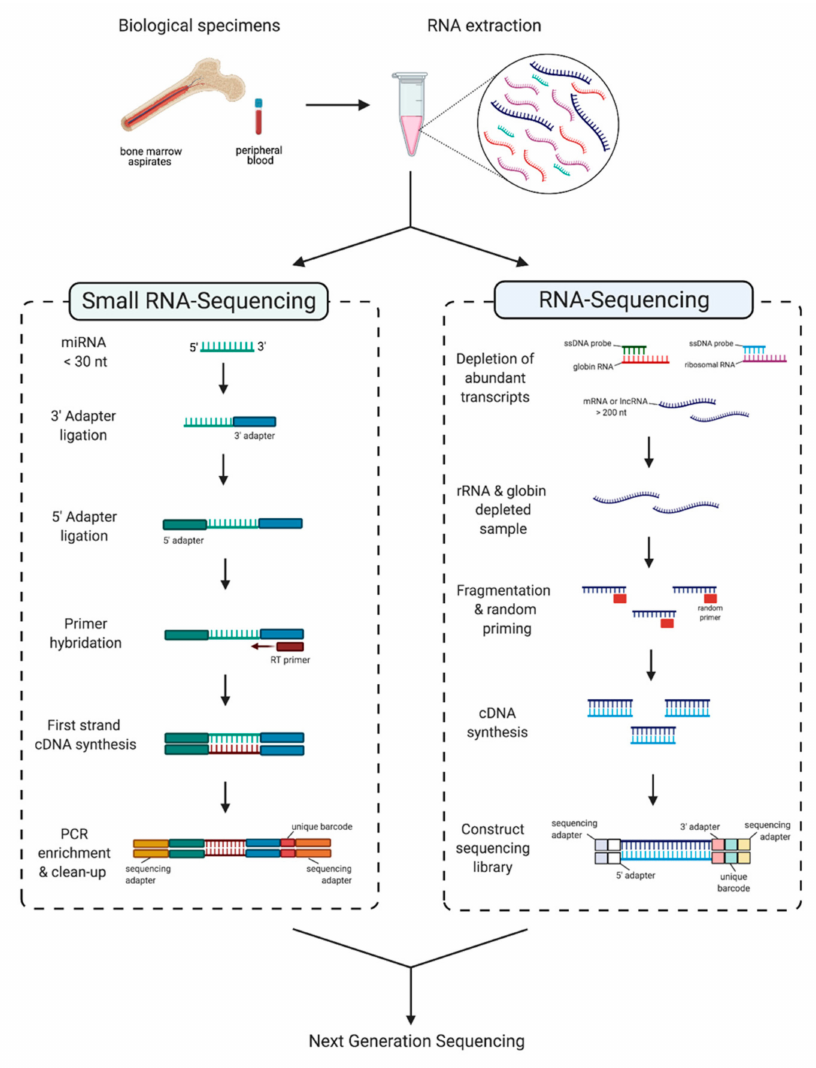
Figure 2. Profiling non-coding RNAs with transcriptome sequencing in B-ALL. In the study of B-ALL, input sample types will vary and can include biological specimens such as the bone marrow, peripheral blood, cord blood, or plasma. RNA is harvested from cells and then assessed for quality. Extracted total RNA from one sample can then be split and used for downstream library construction to profile both small- and long- ncRNAs. Small RNA-sequencing library protocols incorporate additional steps that are required to sequence small RNA species, typically <30 nucleotides. Long non-coding RNAs, as well as mRNAs, are detected with the conventional RNA-Sequencing library preparation protocol. Created with